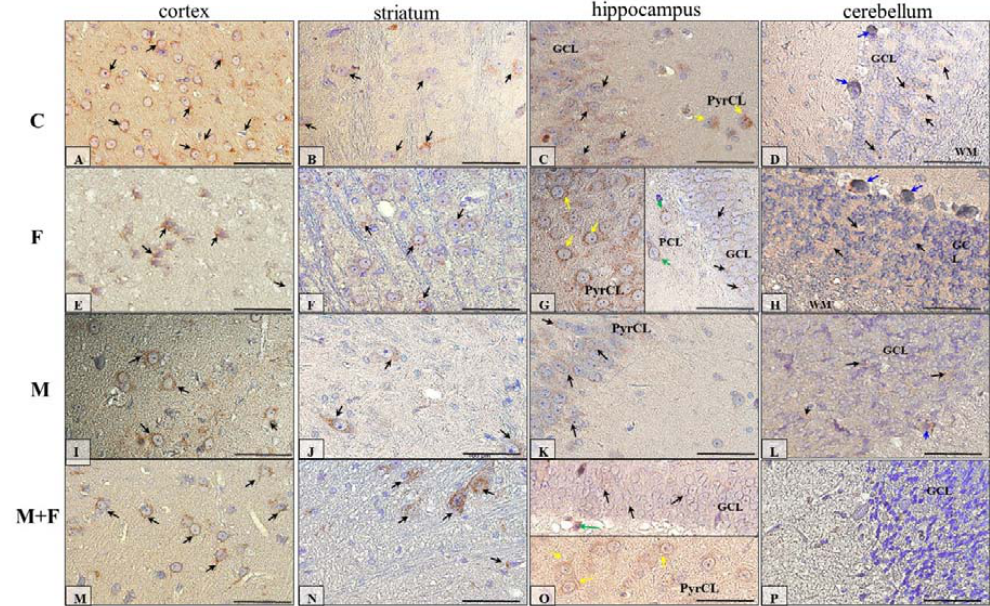
Figure 6. Representative microphotography showing immunoexpression of dopamine receptor D2 (D2R) in the cortex ( A , E , I , M ), striatum ( B , F , J , N ), hippocampus ( C , G , K , O ), and cerebellum ( D , H , L , P ) in rats from the control ( A – D ), fluoride ( E – H ), morphine ( I – L ), and morphine and fluoride ( M – P ) groups. IHC reaction. Scale bar 50 μ m. GCL—granular cell layer, MCL—molecular cell layer, PCL—polymorphic cell layer, PyrCL—pyramidal cell layer, WM—white matter. Black arrows—neurons of the neocortex or striatum or GCL from the hippocampus or cerebellum, green arrows—neurons of the PCL of the dentate gyrus, yellow arrows—neurons of the PyrCL cornu ammonis, blue arrows—Purkinje cells of the ganglion cell layer of the cerebellar cortex.